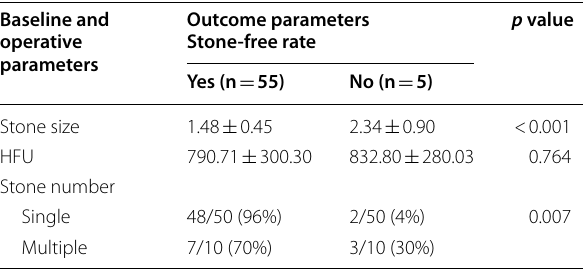
Table 4 Comparison between baseline parameters with